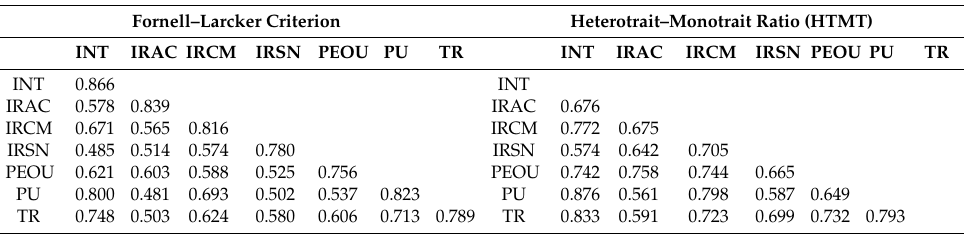
Table 3. Discriminant Validity.